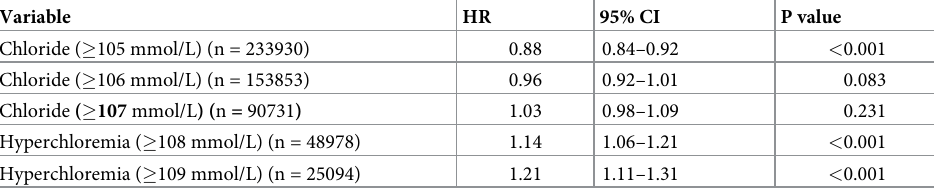
Table 5. Multivariate analysis (Cox regression with same patients clustering) for all-cause mortality (n = 556595 tests of 105207 patients) of hyperchloremia